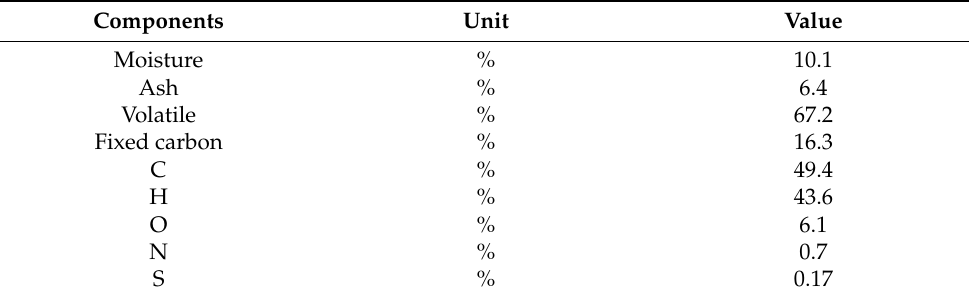
Figure 2. Profiles of solid concentrations with different grid sizes.